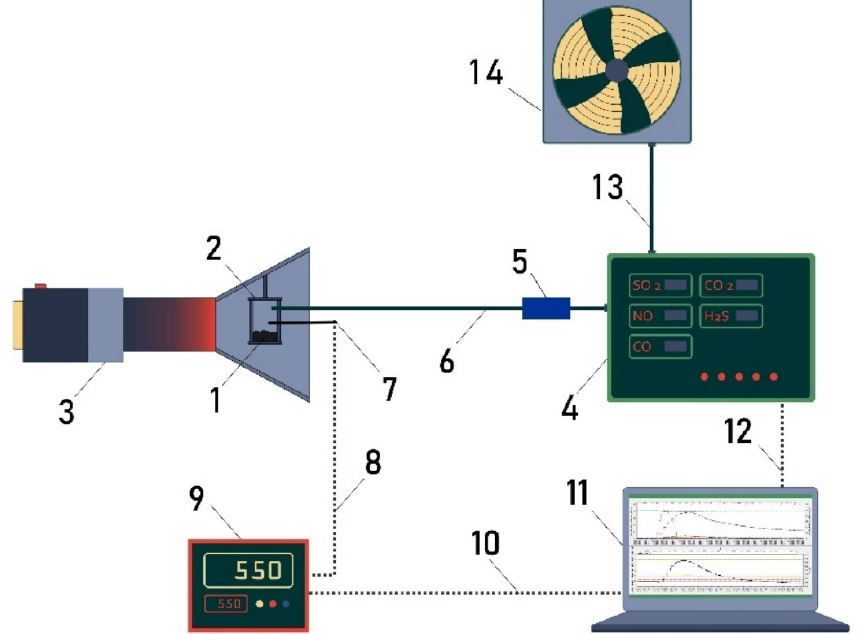
Figure 1. Layout of the experimental stand for determining the composition of the gaseous products of a fuel thermal decomposition. 1—fuel sample; 2—reactor with fuel sample; 3—air heater; 4—gas analyzer; 5—coarse filter; 6—channel for supplying gaseous products of fuels thermal decomposition to gas analyzer with filtration system; 7—thermocouple; 8—thermocouple signal converter; 9—communication line between thermocouple and signal converter; 10—communication line between thermocouple signal converter and laptop; 11—laptop; 12—communication line between gas analyzer and laptop; 13—output channel for gaseous products of thermal decomposition of fuel samples; 14—ventilation shaft.